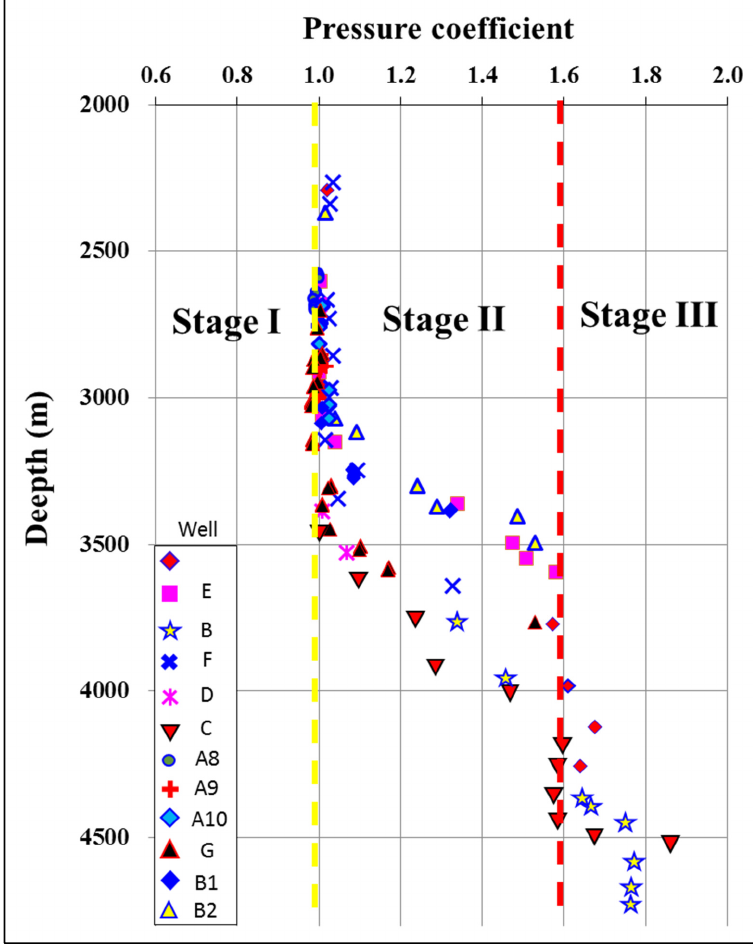
Figure 6. Pore pressure coefficient profile of the study area.